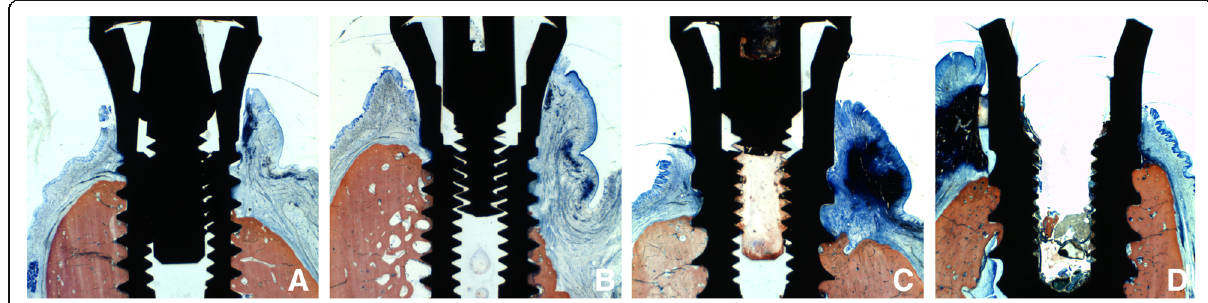
Fig. 6 Microphotographs of ground section representing the healing at ( a , b ) 3.3 mm implants, and ( c ) 3.8 mm and ( d ) 4.25 mm